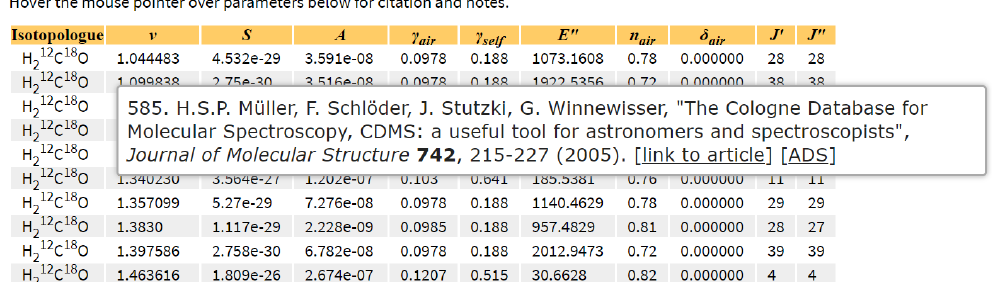
Figure 3. An excerpt of the BibTeX formatted bibliography from HITRAN online for use with L A TEX. This bibliography is for the isotopologue H 12 C 18 O of formaldehyde in the line-by-line section. 2